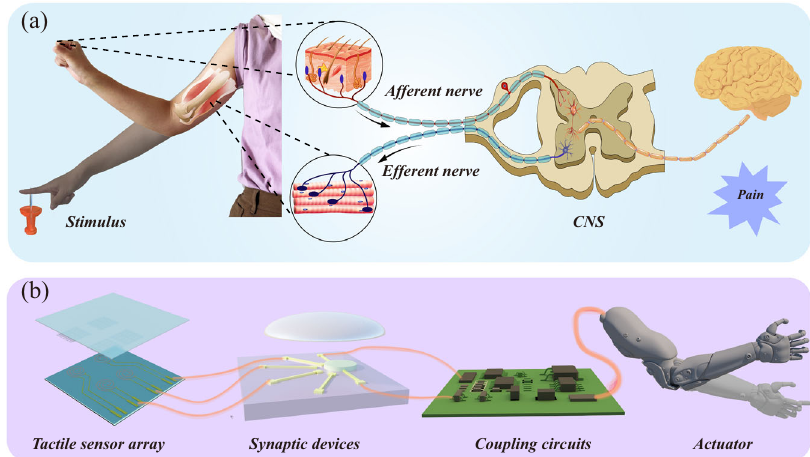
Fig. 1 Arti fi cial system in comparison with the biological somatosensory system. a The biological somatosensory system that is stimulated by external tactile information. Pressure applied onto the mechanoreceptors in the skin can initiate action potentials. The action potentials will be transferred by afferent nerves and combined through the synapse. Afterward, the information will be processed by CNS and transferred to the brain to feel the pain, and at the same time, an action potential will be transmitted to the effector through the efferent nerve to trigger the body ’ s feedback to avoid further injury. b An arti fi cial somatosensory system that mimics the biological pain perception systems composed of several main